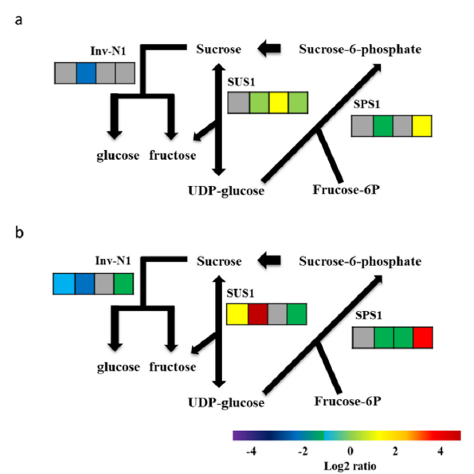
Figure 4. Expression patterns of the sucrose biosynthetic pathway genes in Mh-ACO1 ( a ) and Mh-ACO2 ( b ) RNAi transgenic banana fruits. Relative mRNA abundances were visualized based on qRT-PCR data. Four continuous blocks from left to right indicate that fruits were harvested at stages 1, 3, 5, and 7. Log2 transformed values of relative transcript abundance was normalized with the wild type banana. Gene expression levels are shown with a rainbow color scale. Red indicates high relative expression, yellow indicates moderate relative expression, and green indicates low relative expression. Genes without di ff erential expression between transgenic banana and wild type are shown by grey